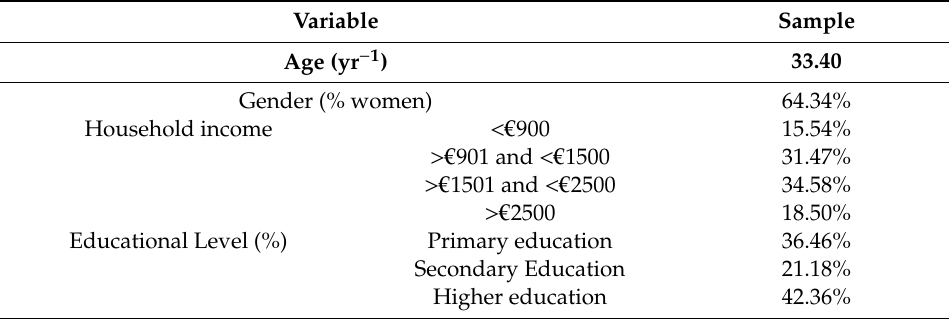
Table 1. Percentage of the characteristics of the sample.